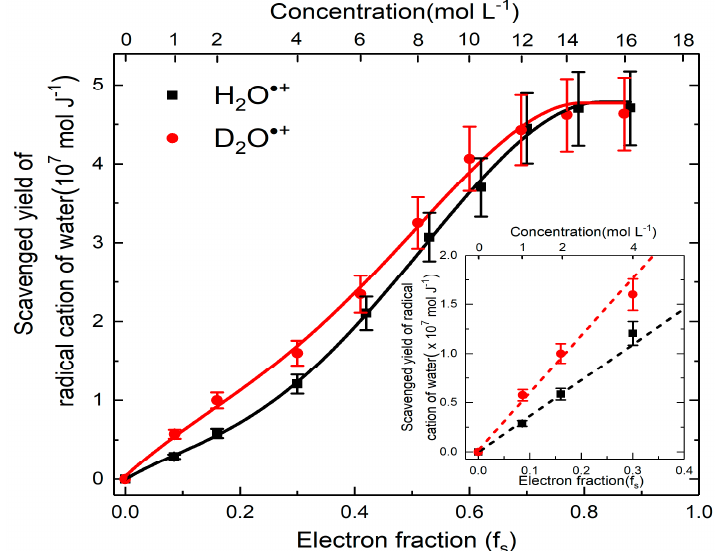
Figure 7. Yields of H 2 O •+ scavenging versus concentration case of H 2 SO 4 and D 2 SO 4 . The difference between H 2 SO 4 and D 2 SO 4 are zoomed in insert figure to better present the isotope effect in proton transfer.